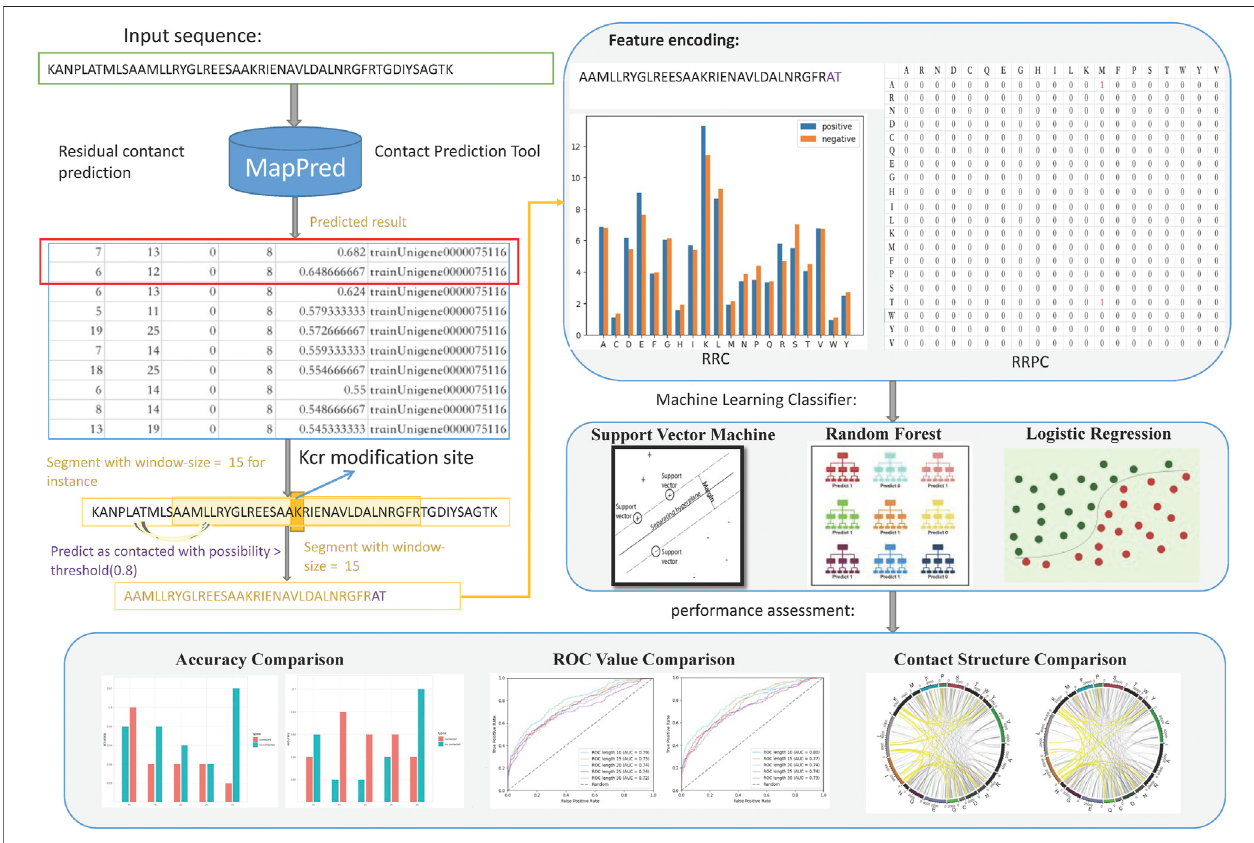
FIGURE 1 | Flowchart of this paper; the main steps are data pre-processing, feature encoding, classi fi cation, and performance assessment. In data pre- processing, whole peptide sequences were used as inputs of a contact prediction tool, which gives a table-formed result, suggesting whether two residues (indices shown in column 1 and column 2) are contacted, and the possibility (in column fi ve) that these two residues are contacted. Then, we append the contacted residues at the tail of the sequence segment and used the expanded segments for feature encoding, obtaining RRC and RRPC features. Then, machine learning methods were involved for Kcr prediction. In the performance assessment part, we compared the accuracy and AUC criterion between spatial and linear features; then, visualization of different window length segments was carried